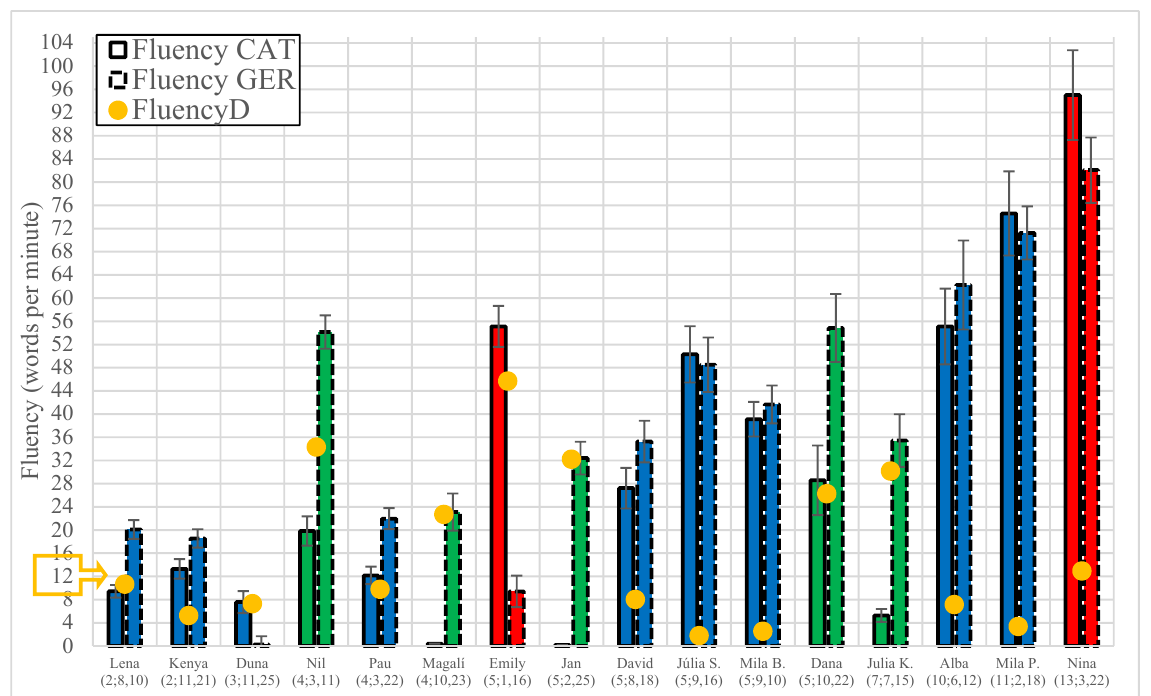
Figure 3. Fluency values for Catalan (solid line) and German (dotted line), as well as language fluency (blue = balanced fluency; green = higher German fluency; red = higher Catalan fluency) for the sixteen bi- and trilinguals according to age.